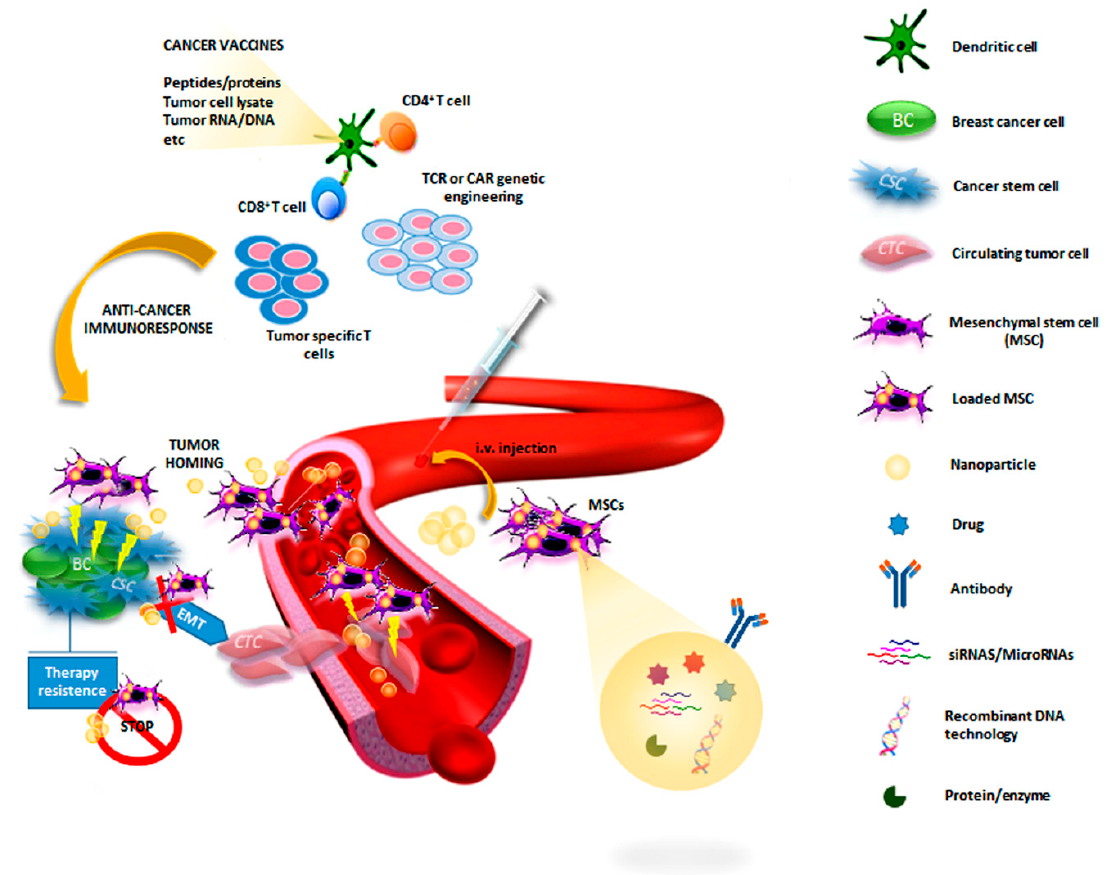
Figure 1. An overview of the main strategies based on BCSC-targeting. After systemic application, engineered immune cells or mesenchymal stem cells (MSCs), tailored to the molecular profile of patients’ breast cancer, home in on the tumor microenvironment and release different specific anti-CSC drugs (proteins, enzymes, recombinant DNA, miRNAs, siRNAs, and chemotherapeutics). Nanoparticles containing different anti-CSC molecules can be administered alone or incorporated into MSCs to reach the tumor microenvironment and deliver drugs.